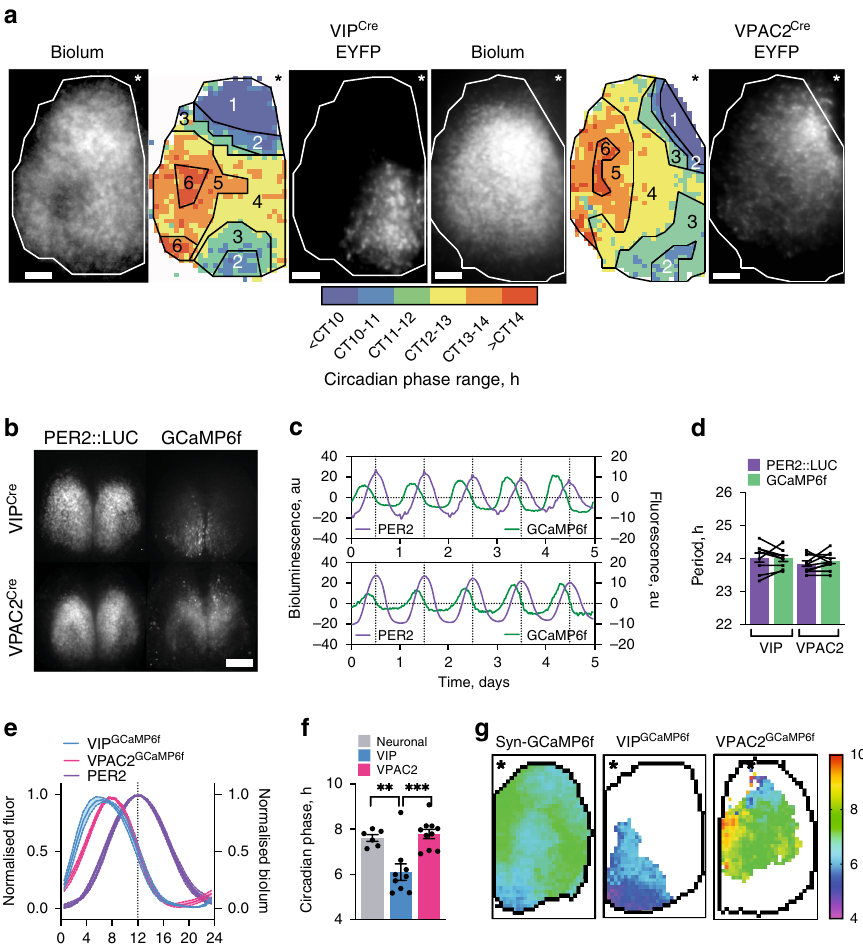
Fig. 1 Regional distribution and circadian phase of VIP Cre and VPAC2 Cre cells in SCN. a Registration of VIP Cre and VPAC2 Cre cells to corresponding phase maps of SCN spatiotemporal bioluminescent wave. For both cell types, left panel shows projections of average bioluminescence emissions recorded by CCD; middle panel shows the corresponding phase map categorically coloured as 1-h phase bins overlaid with manually annotated sequential phase clusters; and right panel shows distribution of Cre-expressing cells revealed by Cre-conditional EYFP intensity. The perimeter of the SCN is delineated by the white outline, and the location of the third ventricle is denoted by asterisks. Note registration of VIP Cre and VPAC2 Cre cells with earlier and later phase clusters, respectively. These images are representative of a set of three experiments for VIP EYFP and VPAC2 EYFP each, which are presented in Supplementary Fig. 3. Scale bars = 50 µ m. b Representative micrographs of Per2::Luciferase in register with GCaMP6f conditionally targetted to VIP (upper) or VPAC2 (lower) cells. Scale bars = 250 µ m. c Representative detrended Per2::Luciferase (purple) and conditionally targetted GCaMP6f traces (green) from recordings from VIP Cre (upper) and VPAC2 Cre (lower) slices. d Paired period measures of Per2::Luciferase (purple) and conditional GCaMP6f (green) rhythms. e Phase-aligned normalised single cycles of Per2::Luciferase (two overlaid purple) versus corresponding VIP GCaMP6f (blue) and VPAC2 GCaMP6f (pink) cycles. Lines and shading are mean ± SEM. f Circadian-normalised phase measures for pan-neuronal GCaMP6f (grey), VIP GCaMP6f (blue) and VPAC2 GCaMP6f (pink), (** p = 0.004, *** p = 0.0005). g Circadian-normalised phase-maps of neuronal GCaMP6f (left), VIP GCaMP6f (middle) and VPAC2 GCaMP6f (right). SCN outlines from corresponding Per2::Luciferase phase-maps, asterisks mark third ventricle. In all histograms, individual points represent individual SCN slices and bars are mean ± SEM. Statistics: d paired two-tailed t -tests; f ordinary one-way ANOVA with Holm-Sidak ’ s correction for multiple comparisons. For GCaMP6f imaging ( d – f ): n = 6, 9 and 10 for neuronal, VIP GCaMP6f and VPAC2 GCaMP6f . Only signi fi cant comparisons ( p < 0.05) are shown. Source data are provided as a source data fi